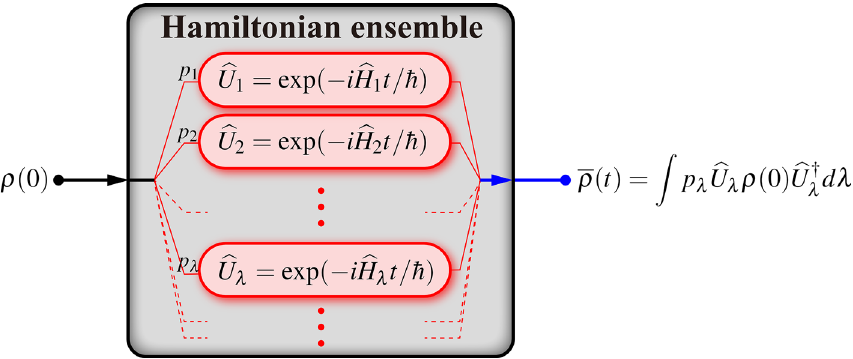
H (cid:31) (cid:31)